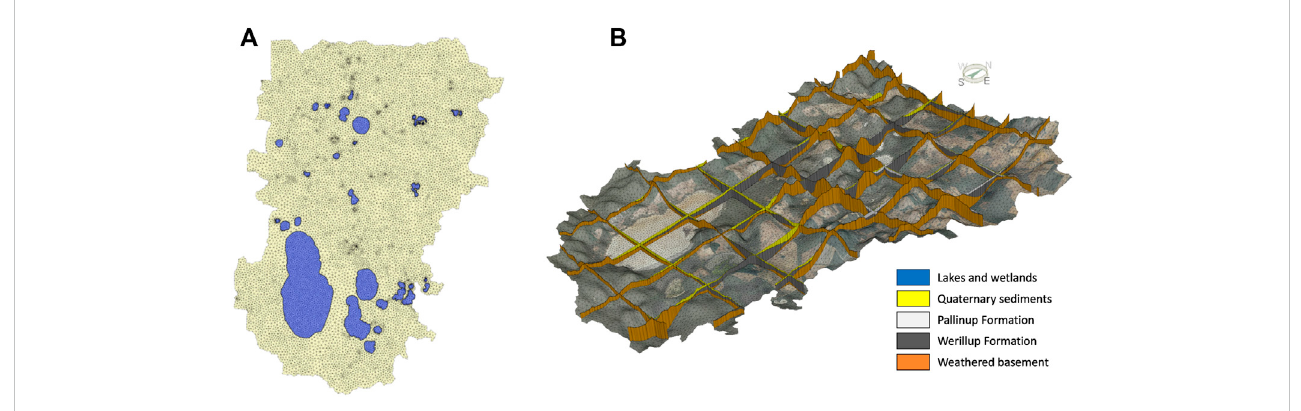
FIGURE 4 Groundwater model mesh and main surface water compartments (A) , and fence diagram illustrating the distribution of the main hydrogeological units (B)